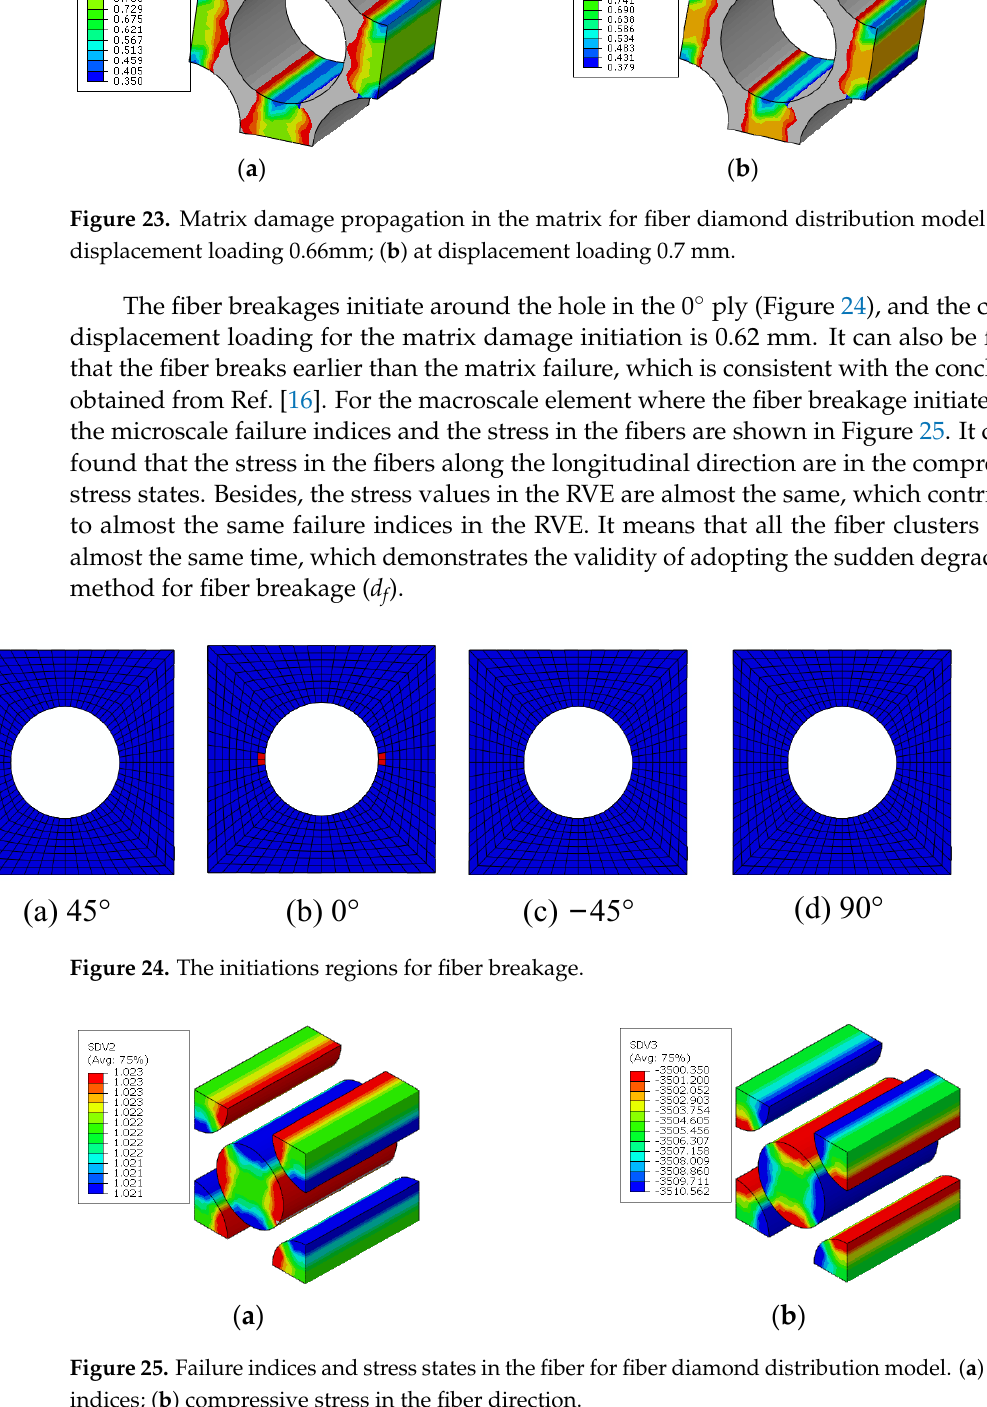
failure indices; ( b ) compressive stress in the fiber direction. indices; ( b ) compressive stress in the fiber